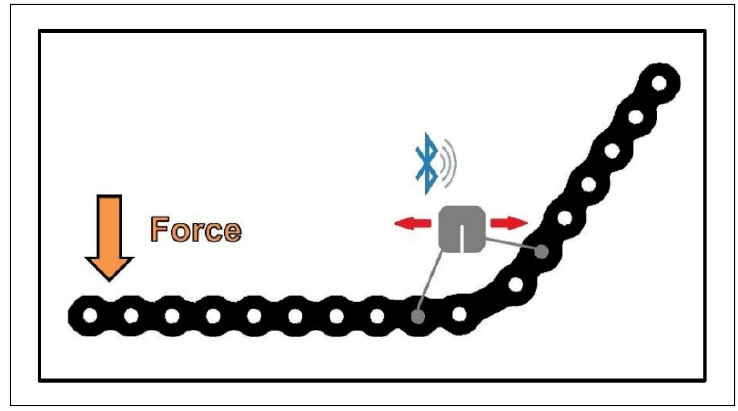
Figure 2. Schematic image of the functionality of the strain sensor.